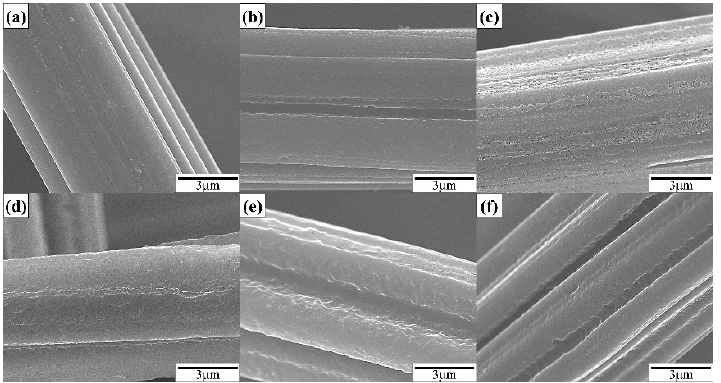
Figure 2. The SEM micrographs of the graphite felt : ( a ) GF, ( b ) TGF, ( c ) V10-TGF, ( d ) V0-EGF, ( e ) V3-EGF, and ( f ) V10-EGF.